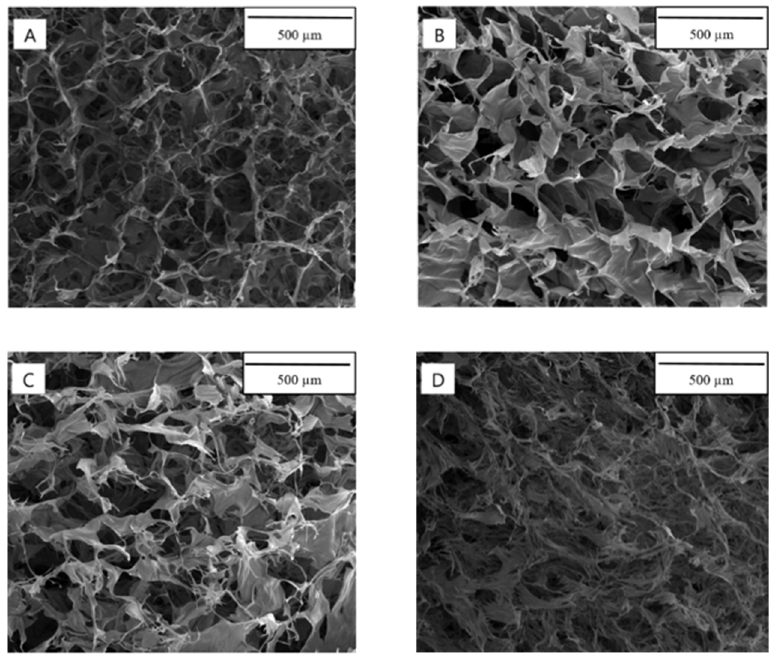
Figure 2. SEM images of scaffolds based on ( A ) 50DAC/50HA, ( B ) 60DAC/40HA, ( C ) 70DAC/30HA, ( D ) 80DAC/20HA (1 × 200).